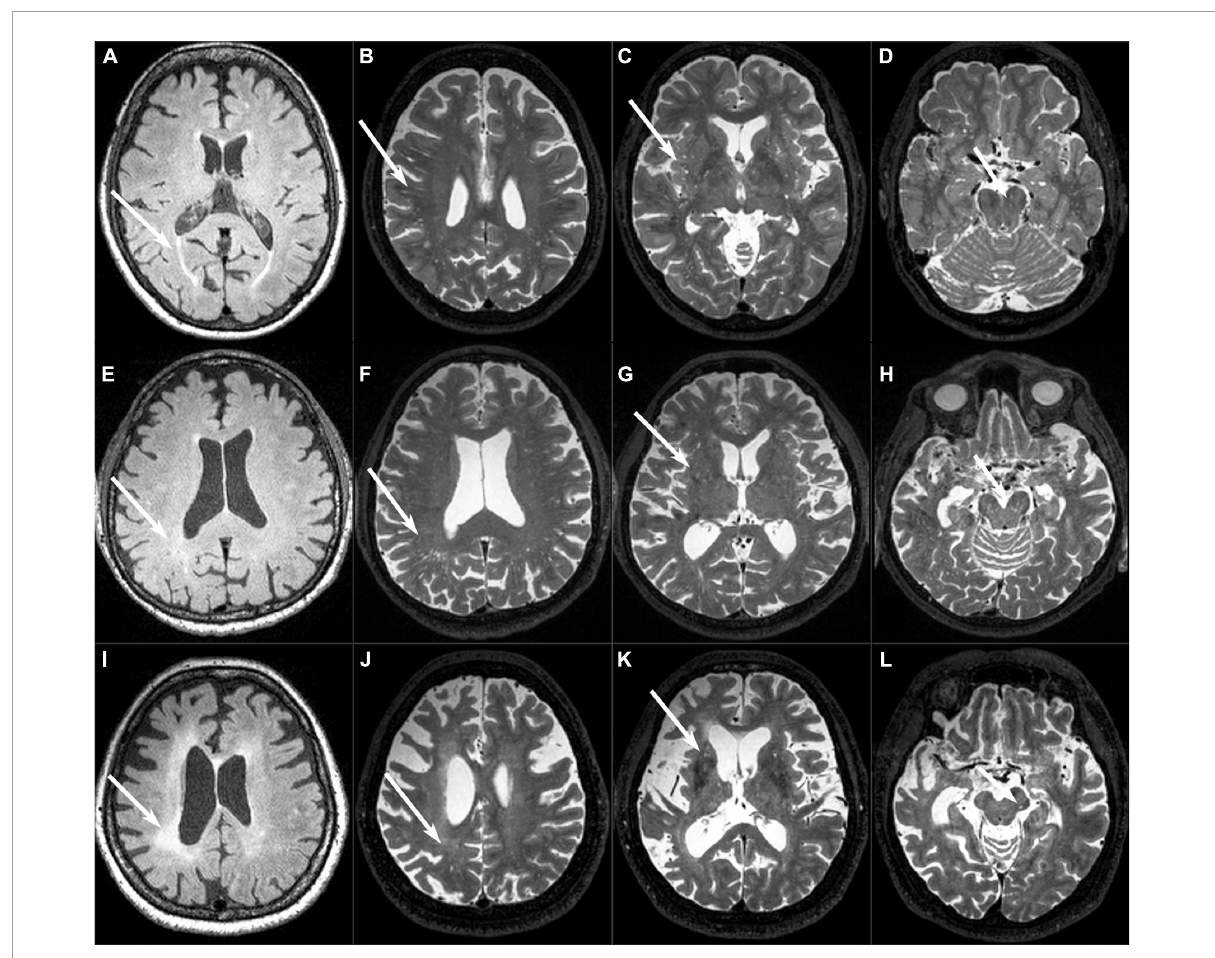
FIGURE1 Examples of EPVS and WMH. (A–D) A normal 82-year-old female control subject had grade 1 PWMH, grade 3 CSO-EPVS, grade 2 G-EPVS, and two BS-EPVS. (E–H) An 85-year-old male patient with PSP-RS had grade 1 PWMH, grade 3 CSO-EPVS, grade 2 BG-EPVS, and 11 BS-EPVS. (I–L) A 63-year-old female patient with bvFTD had grade 3 PWMH, grade 1 CSO-EPVS, grade 1 BG-EPVS, and 1